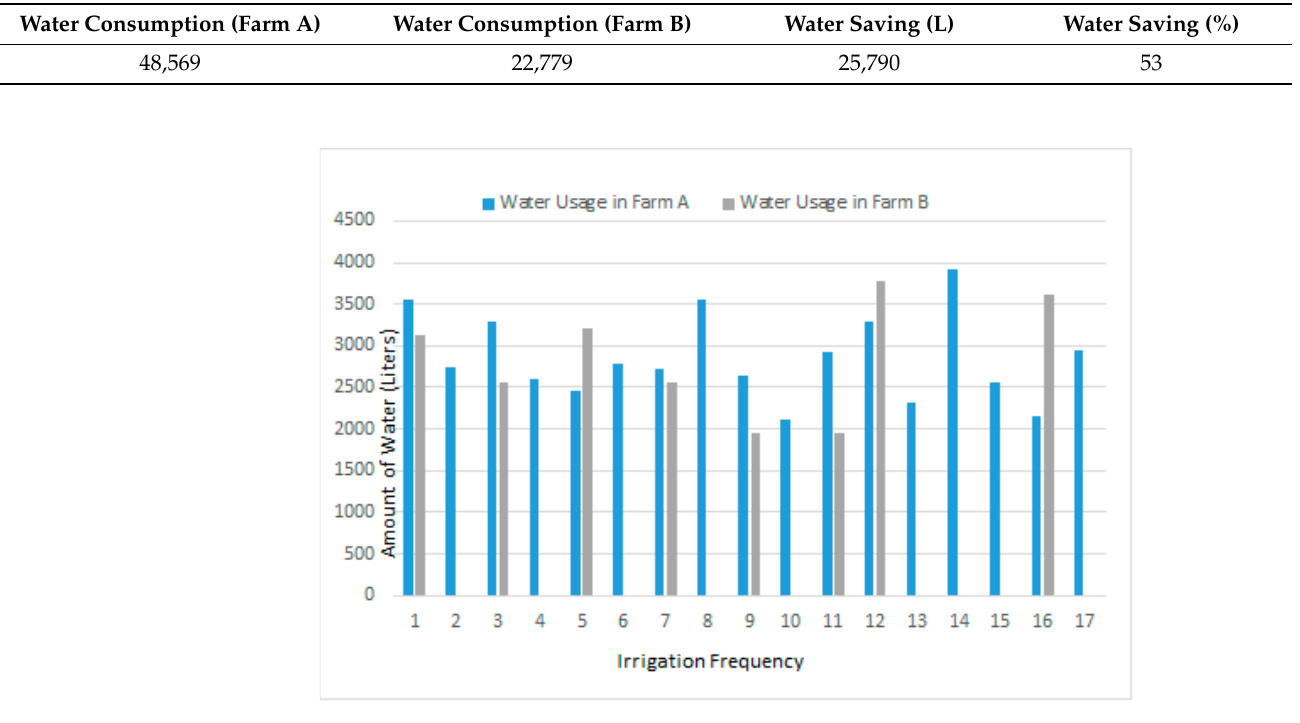
Figure 12. Irrigation frequency and water usage efficiency.